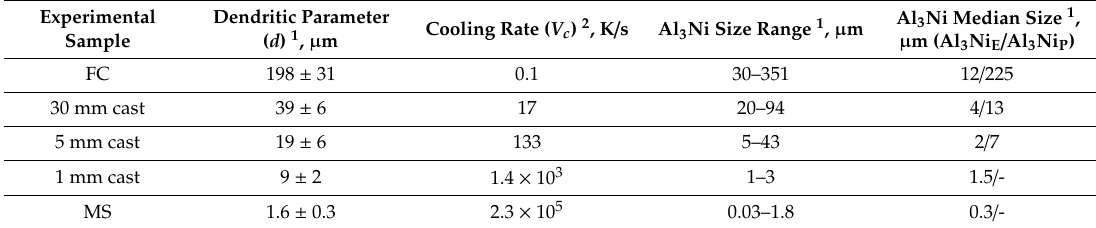
Table 2. Microstructure peculiarities of the Al8Zn7Ni3Mg alloy depending on the cooling rate. Experimental Sample